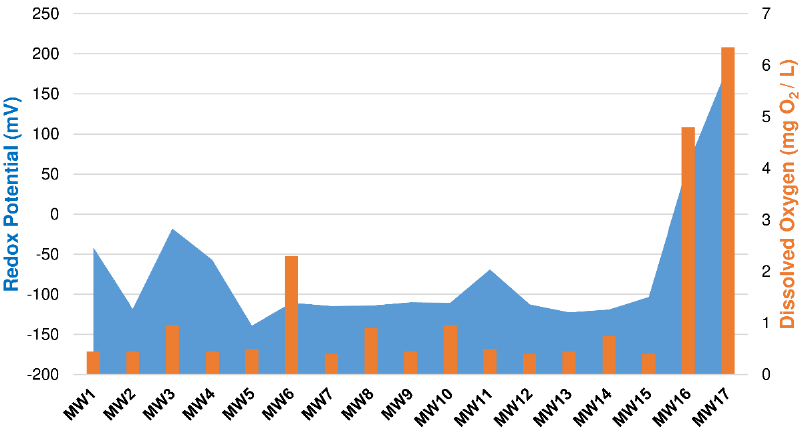
Figure 4. Correlation between the median values of dissolved oxygen and redox potential observed in each monitoring well.